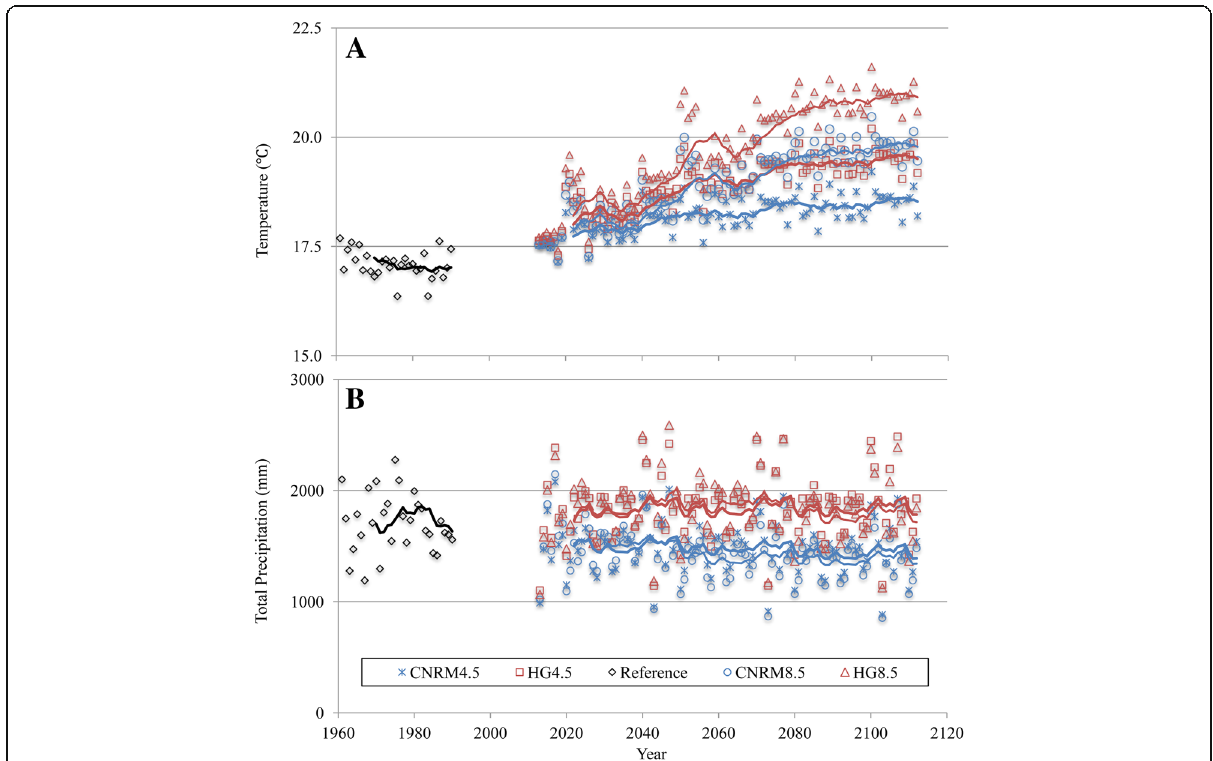
Fig. 5 Historical reference climate data and projected pattern of change. a , b Mean annual air temperature and total annual precipitation for the next 100 years based on four downscaled climate change projections, respectively. Lines represent the 10-year moving average for each